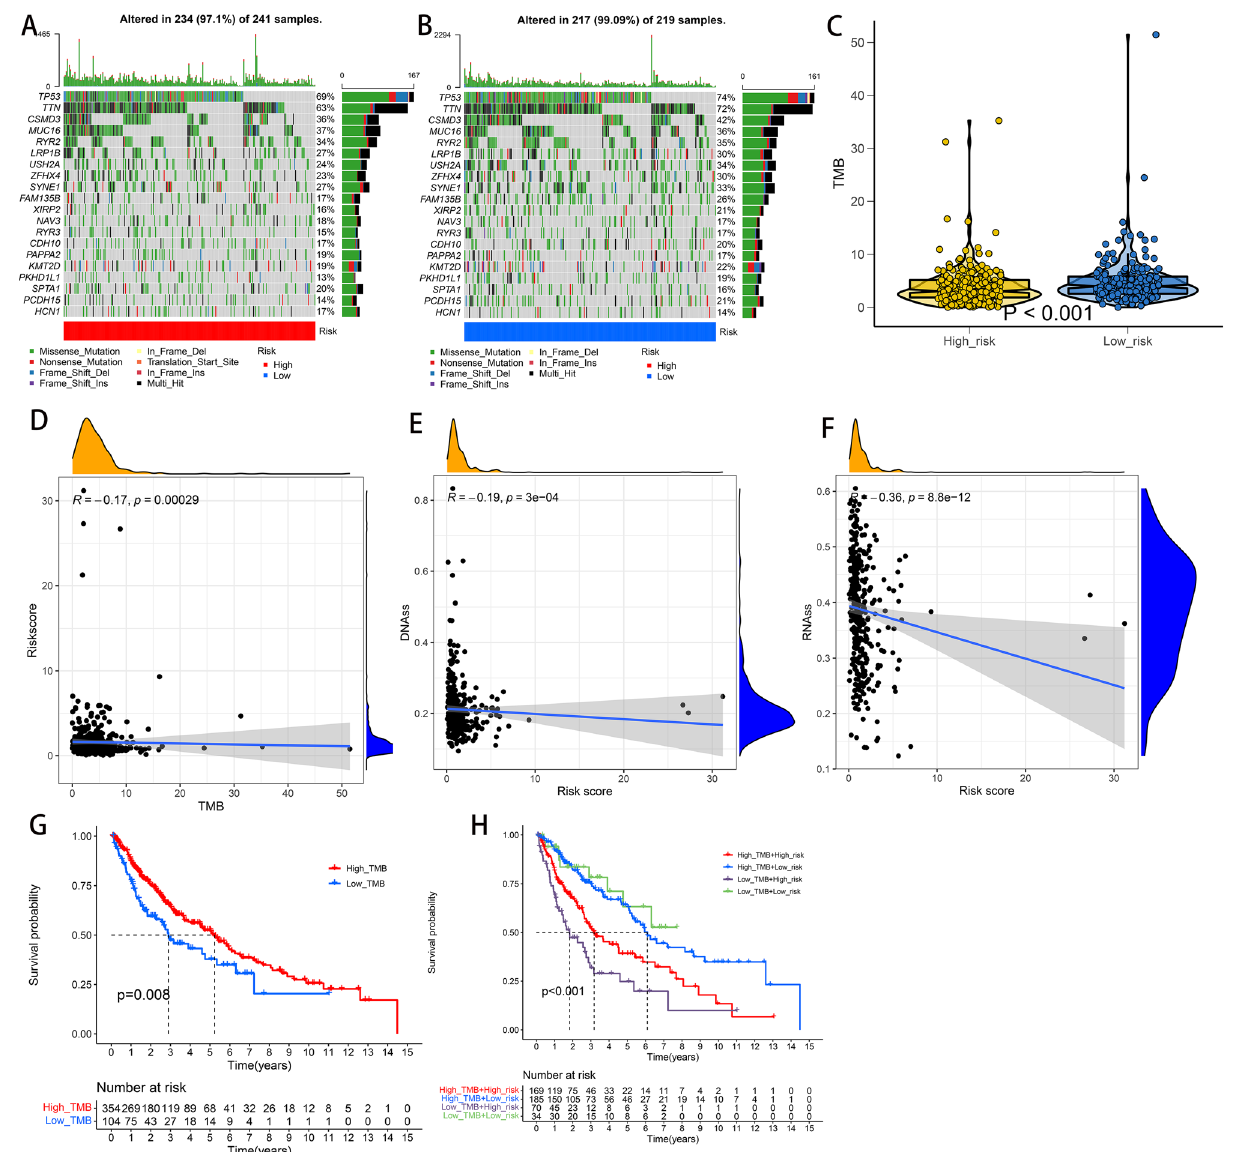
highest mutation frequency in low-risk and high-risk groups. ( C ) Distribution of TMB in two groups. ( D–F ) Relationship between risk score and TMB, DNAss and RNAss. ( G,H ) Kaplan–Meier survival curves revealed the prognostic value of TMB with or without combination with the risk score. TCGA The Cancer Genome Atlas, TMB tumor mutation burden, DNAss DNA stemness scores, RNAss RNA stemness